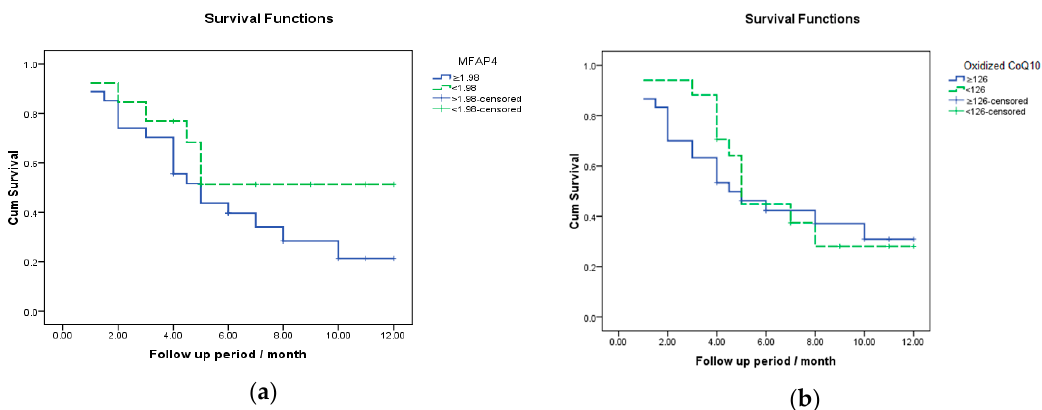
Figure 4. ( a ) Kaplan–Meier survival analysis for microfibrillar-associated protein 4 (MFAP4) in the prediction of death in hepatocellular carcinoma (HCC) patients; ( b ) Kaplan–Meier survival analysis for oxidized CoQ10 in the prediction of death in HCC patients. Cum Survival: cumulative survival.